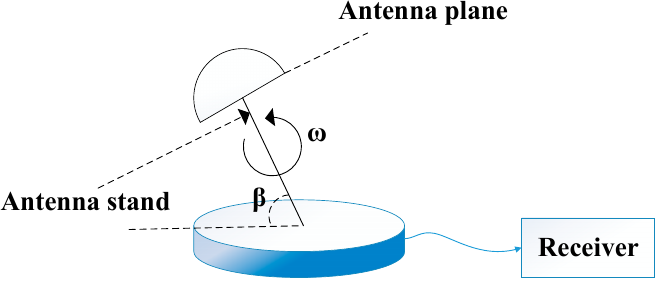
Figure 1. Rotating single-antenna detection model. β in Figure 1 means the angle between the antenna stand and the horizontal plane.